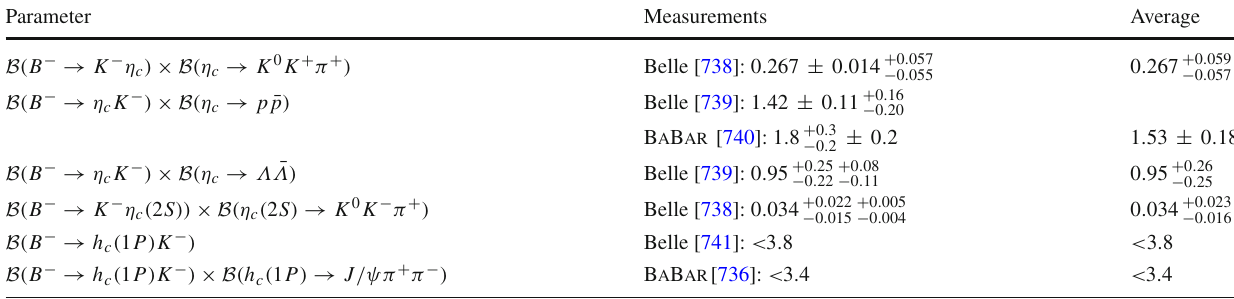
Table 163 Decays to charmonium other than J /ψ and one kaon III [ 10 − 6 ]